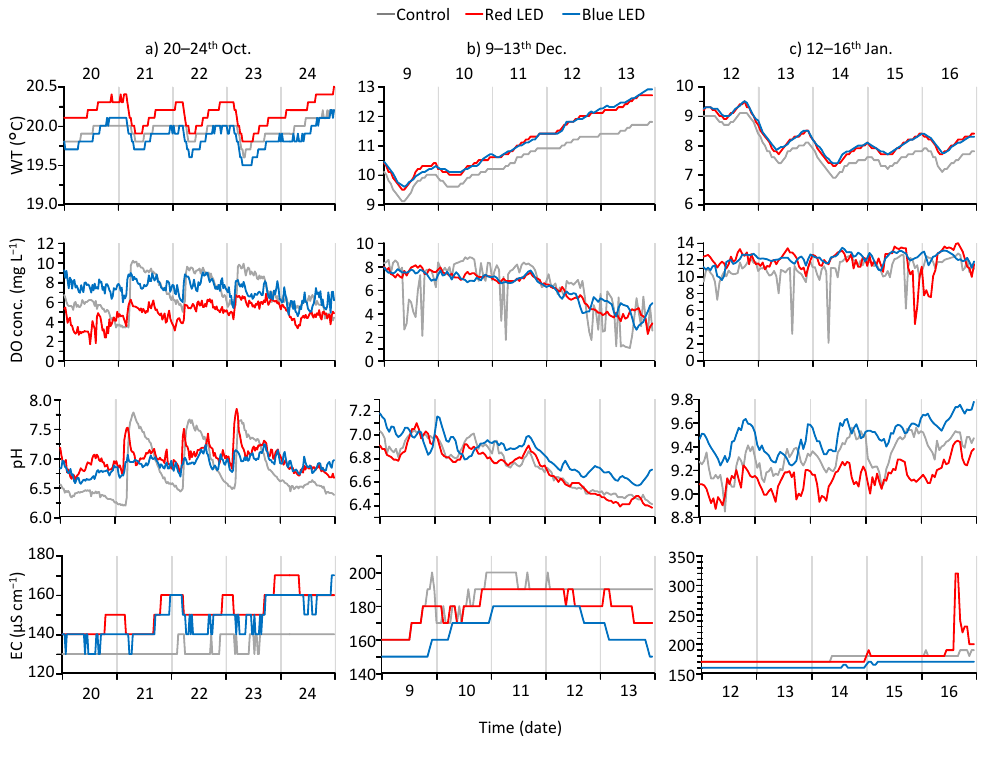
Figure 4. Hourly changes in water quality (water temperature, DO, pH, and EC) of the 3 depressions for 5 days (( a ): 20 – 24 October, ( b ): 9 – 13 December, ( c ): 12 – 16 January). The second example is from 9 to 13 December, with rainfall on the second (7.5 mm) and third (84.5 mm) days (Figure 4b). The water temperature decreased from midnight to